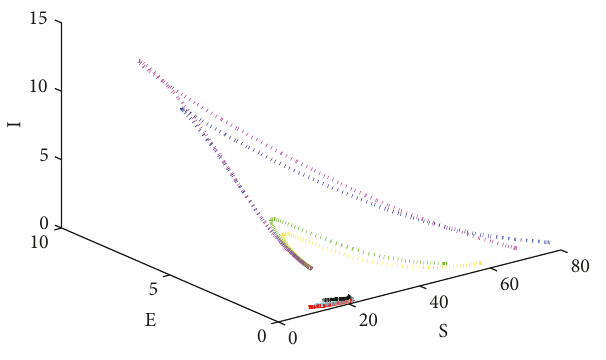
Figure 8: The tendency of 𝑆 , 𝐸 , and 𝐼